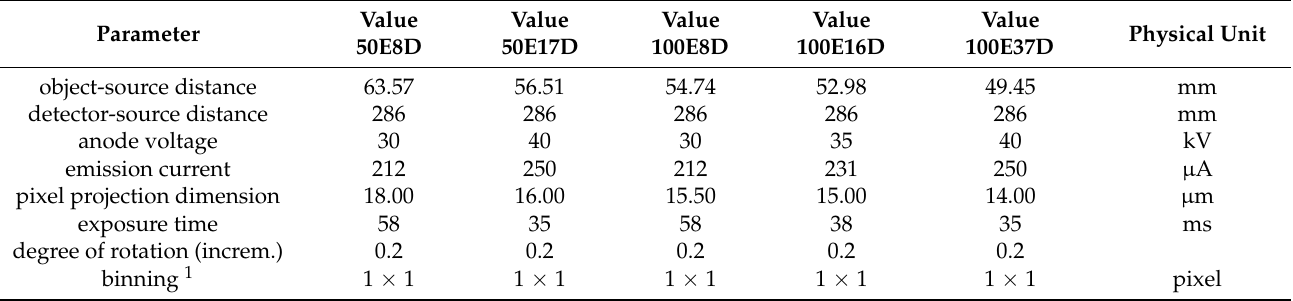
Table A11. Values of set parameters on SkyScan 1275 for scanning of the 13 liver samples.